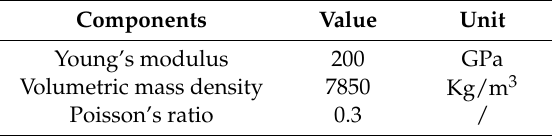
Table 3. Material properties of truss members.